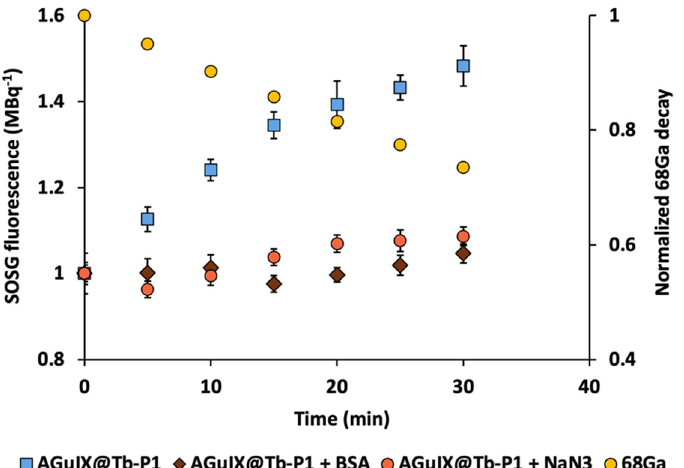
Figure 1. Kinetics of singlet oxygen production by AGuIX@Tb-P1 under Gallium-68 exposure. Experiments were performed with 7.35 µ M AGuIX@Tb-P1 (P1 equivalent), 10 µ M fluorescent probe and 15–20 MBq Gallium-68 ( 68 Ga). Probe fluorescence signals were revealed every 5 min during radionuclide irradiation. The production of singlet oxygen was inhibited by adding sodium azide (NaN 3 ) or bovine serum albumin (BSA) to the reaction mixture. The radioactive decay was estimated and plotted as a function of experiment delay. Three independent experiments were performed; each point corresponds to the mean ± SD.